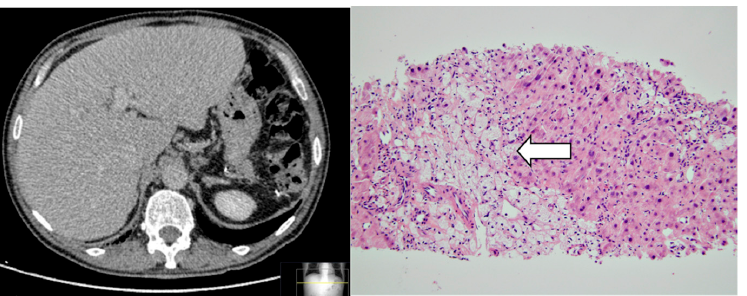
Figure 2. ( Left ): Abdominal computed tomography showing hepatomegaly. ( Right ): Hematoxylin and eosin (HE) staining of liver tissue (original magnification ×20): note the presence of clusters of foamy histiocytes involving liver tissue due to lipid deposition (white arrow).